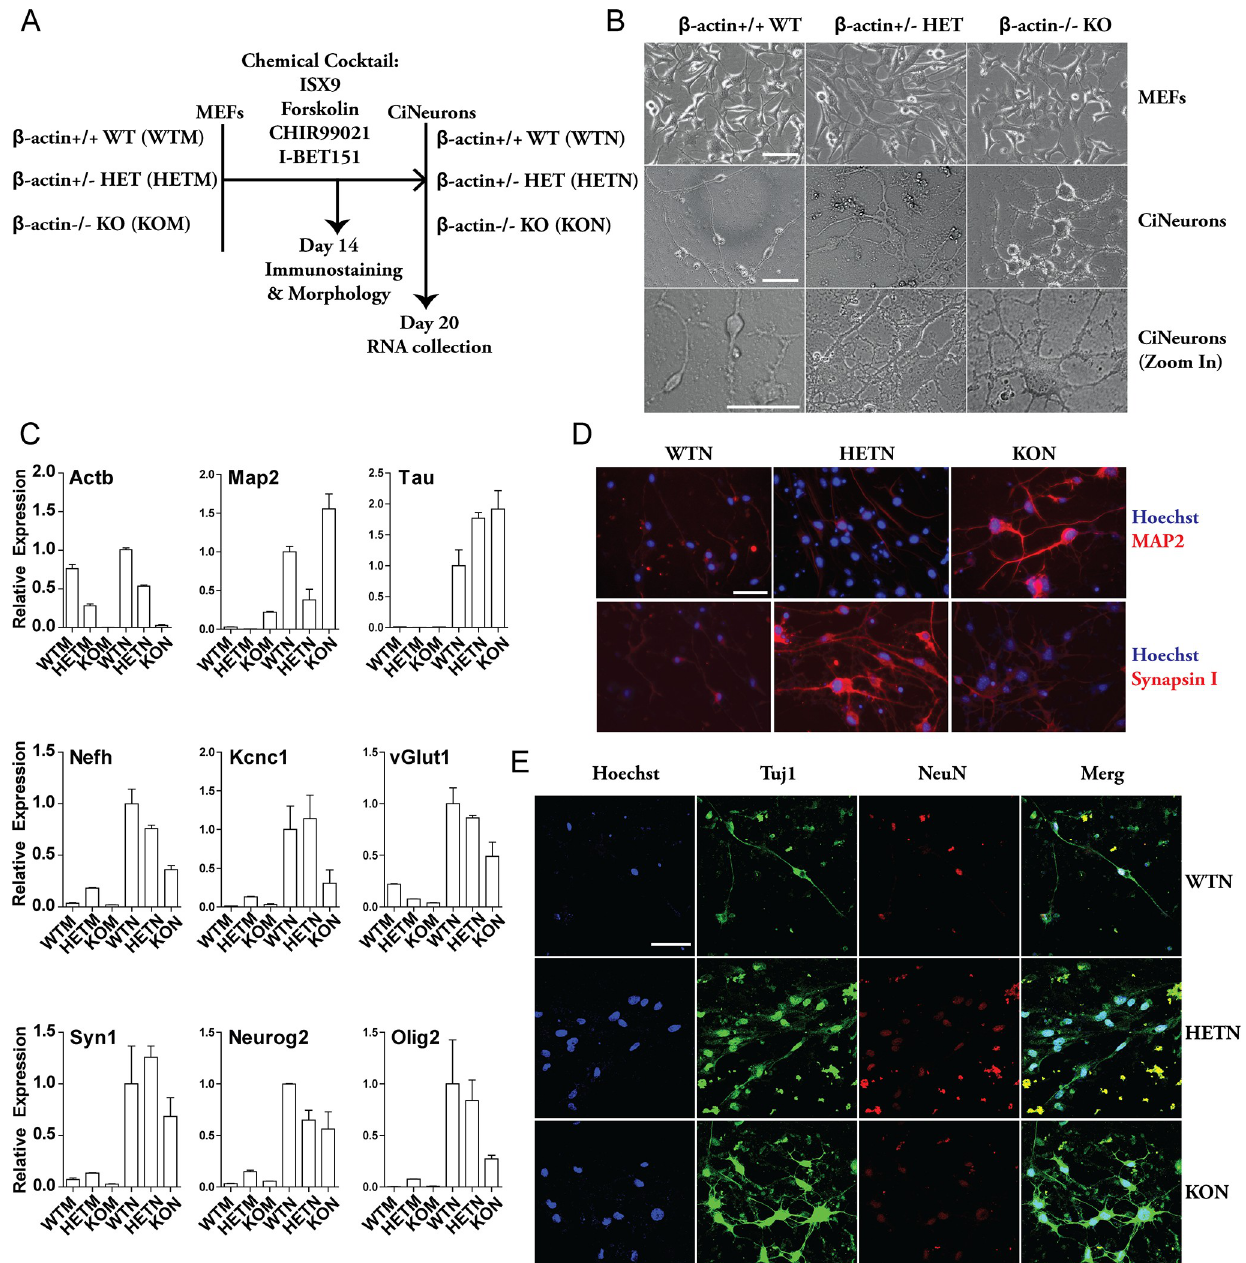
Fig 2. Direct reprograming of MEFs into chemically induced neurons (CiNeurons). (A) Schematics of experimental setup of direct reprograming of MEFs to CiNeurons by small molecule cocktail. ( B) Cell morphology of WT, HET and KO MEFs and the corresponding CiNeurons. Scale bar: 50 μ m. (C) qPCR quantification of relative gene expression in MEFs and CiNeurons. Nono housekeeping gene was used for normalization, and the expression level of WTN was set as 1 for each gene. Data are the summary of 2 independent batches of reprogramed cells. Error bar: S.E.M. (D) Immunofluorescence of Synapsin I and MAP2 staining in CiNeurons, Scale bar: 50 μ m. (E) Confocal images of Tuj1 and NeuN staining in CiNeurons, Scale bar: 50 μ m.